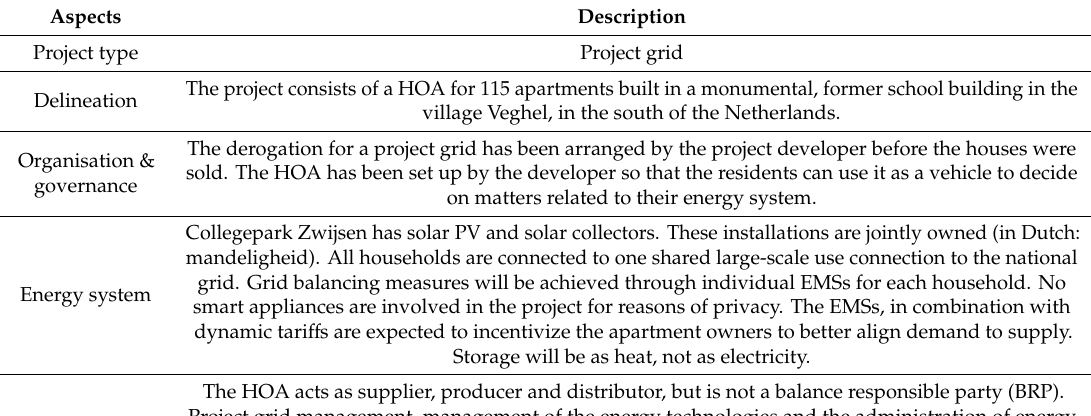
Table 5. Case study description Collegepark Zwijsen.